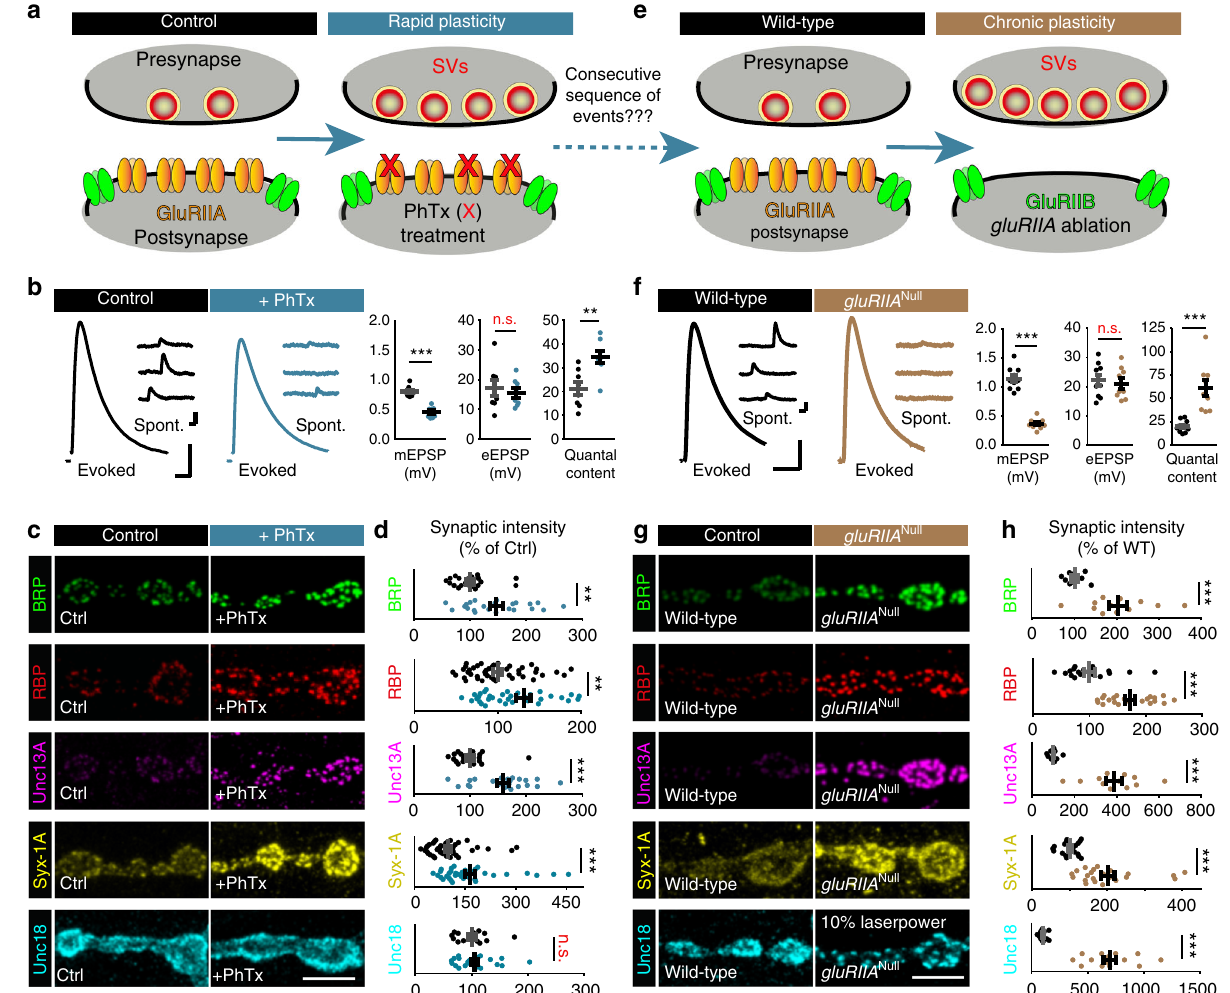
Fig. 1 Rapid homeostatic plasticity regulates AZ protein levels. a Sketch of investigated conditions for rapid plasticity: control synapses (left) are compared with rapid plasticity (10 min of PhTx (red “ X ” ); right). Rapid plasticity increases the number of SVs released (red). b , f Representative traces of eEPSP (evoked), mEPSP (spont.) and their quanti fi cation in Ctrl (black) and PhTx (blue) treated ( b ) or wild-type (black) and gluRIIA Null (brown) ( f ) cells. c , g NMJs labelled with indicated antibodies in Ctrl (black) and PhTx (blue) treated ( c ) or in wild-type (black) and gluRIIA Null (brown) ( g ) animals. d , h Quanti fi cation of BRP, RBP, Unc13A, Syx-1A, and Unc18 AZ-levels in % of Ctrl in Ctrl (black) and PhTx (blue) treated ( d ) or in % of wild-type (WT) in wild- type (black) and gluRIIA Null (brown) ( h ) animals. e Sketch of investigated conditions for chronic plasticity: wild-type synapses (left) are compared with gluRIIA Null mutants. Chronic plasticity greatly increases the number of SVs released. See also Supplementary Fig. 1. Source data as exact normalized and raw values, detailed statistics including sample sizes and P values are provided in the Source Data fi le. Scale bars: b , f eEPSP: 25 ms, 5 mV; mEPSP: 50 ms, 1 mV; c , g 5 µ m. Statistics: Student ’ s unpaired T -test was used for comparisons in ( b ) and (( f ) eEPSP) and Mann – Whitney U test for all other